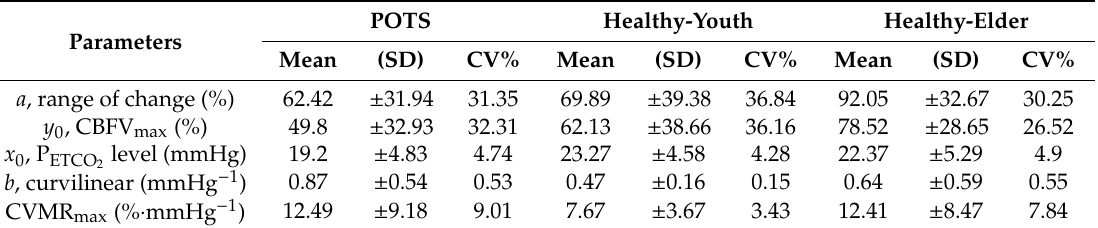
Table 4. Estimation of logistic function parameters using curve-fitting Model II for the three